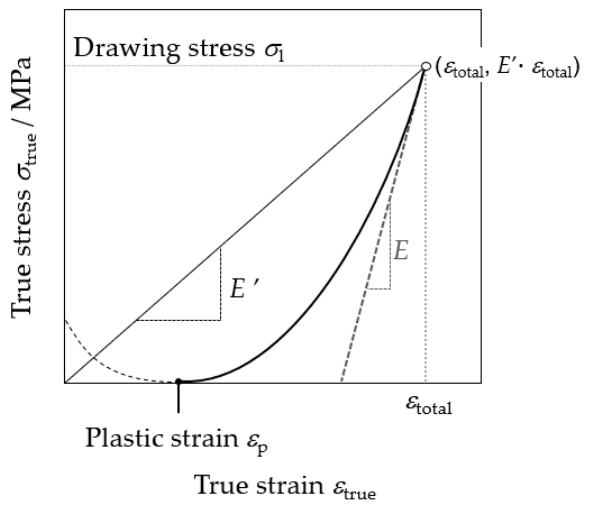
Figure 22. Illustration of the approximated unloading behavior.